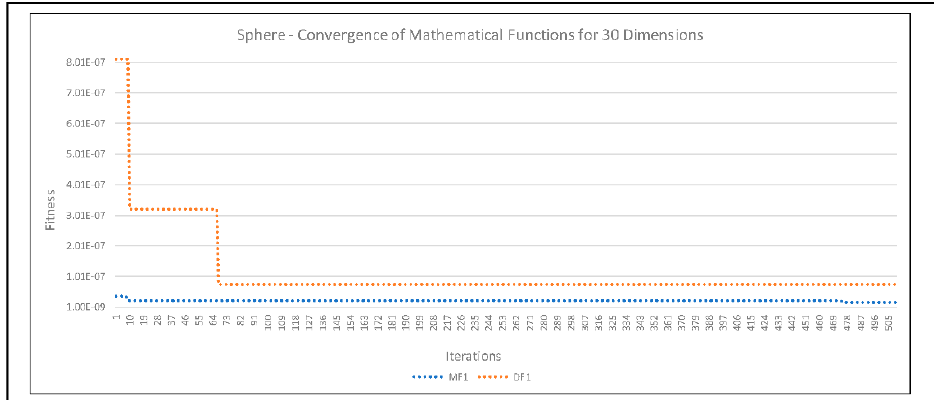
Figure 6. Sphere - Convergence of the DMOA and MTOA algorithms for 30 dimensions. Figure 6. Sphere-Convergence of the DMOA and MTOA algorithms for 30